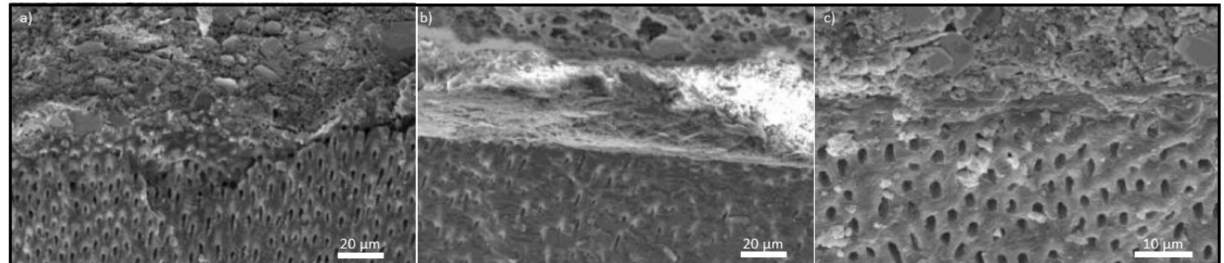
Figure 14. Connection of the dentine of the root canal with the visible dentin tubules after cold filling the root canal with resilon (SEM): ( a ) with a denture in the middle part of the image; ( b ) with resilon in the absence of noticeable filling of the dentinal tubules with replacement material; ( c ) fine particles of sealant are visible in some of the transversely broken dentin tubules.